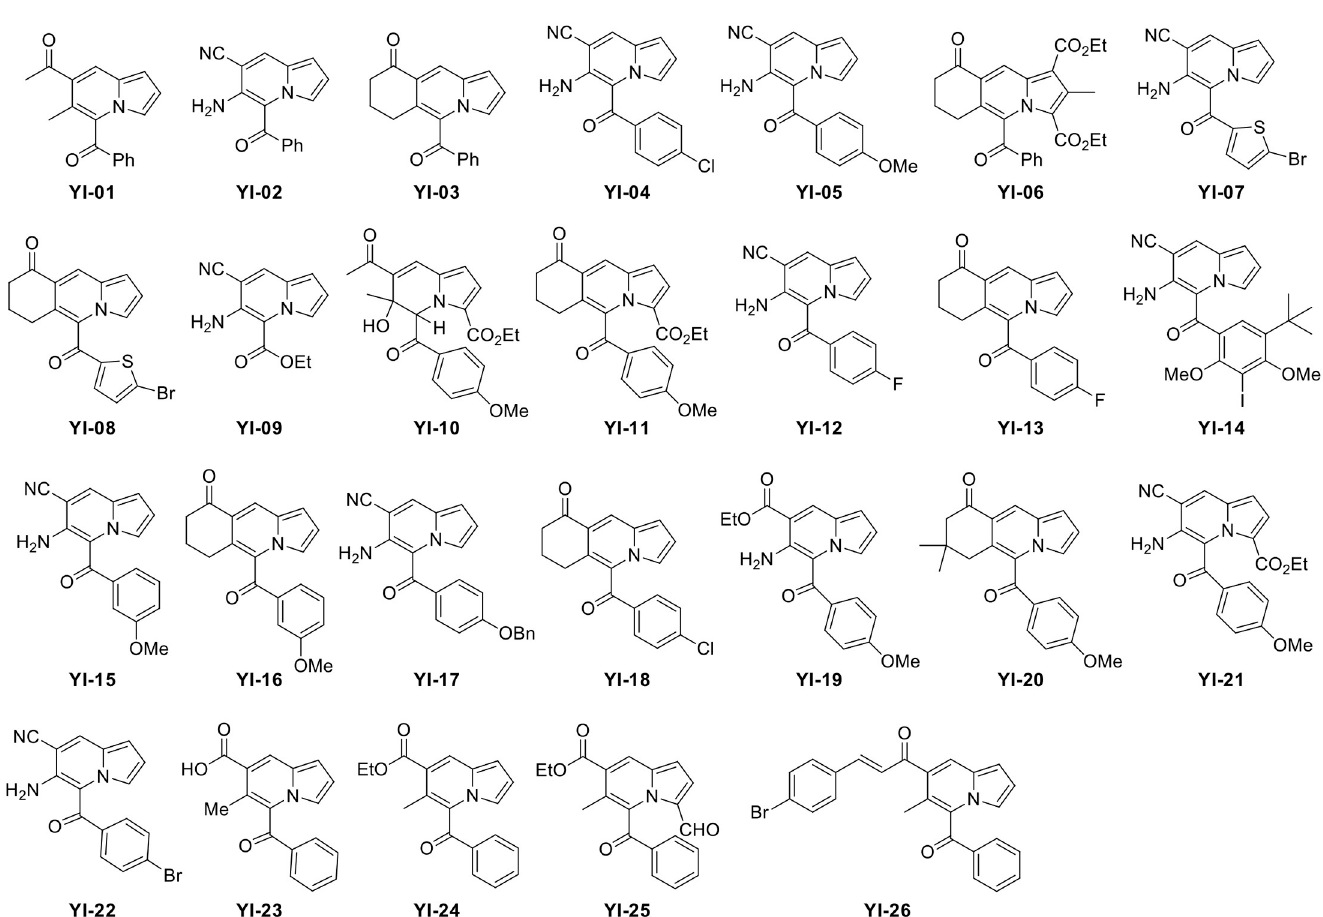
Fig 1. Chemical structures of YI compounds. A chemical library of 26 fluorescent indolizine derivatives.